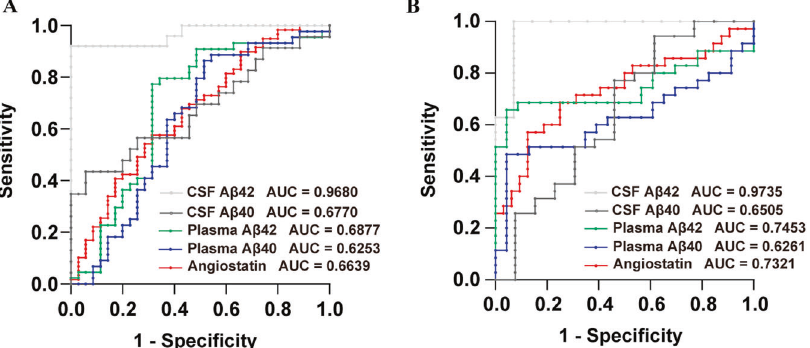
Fig. 4 Receiver operating characteristic (ROC) curves of angiostatin. ROC curves of angiostatin and common biomarkers of AD. Diagnostic value of angiostatin and known biomarkers in distinguishing AD patients from cognitively normal controls ( A ). Diagnostic value of angiostatin and known biomarkers in distinguishing AD patients with APOE- ε 4 from cognitively normal controls ( B Diagnostic value of plasma angiostatin levels for AD To discriminate between AD and CN subjects, the area under the curve (AUC) for plasma angiostatin was 0.6639 ( p = 0.0081, 95% CI = 0.5491 – 0.7787), which was slightly higher than 0.6253